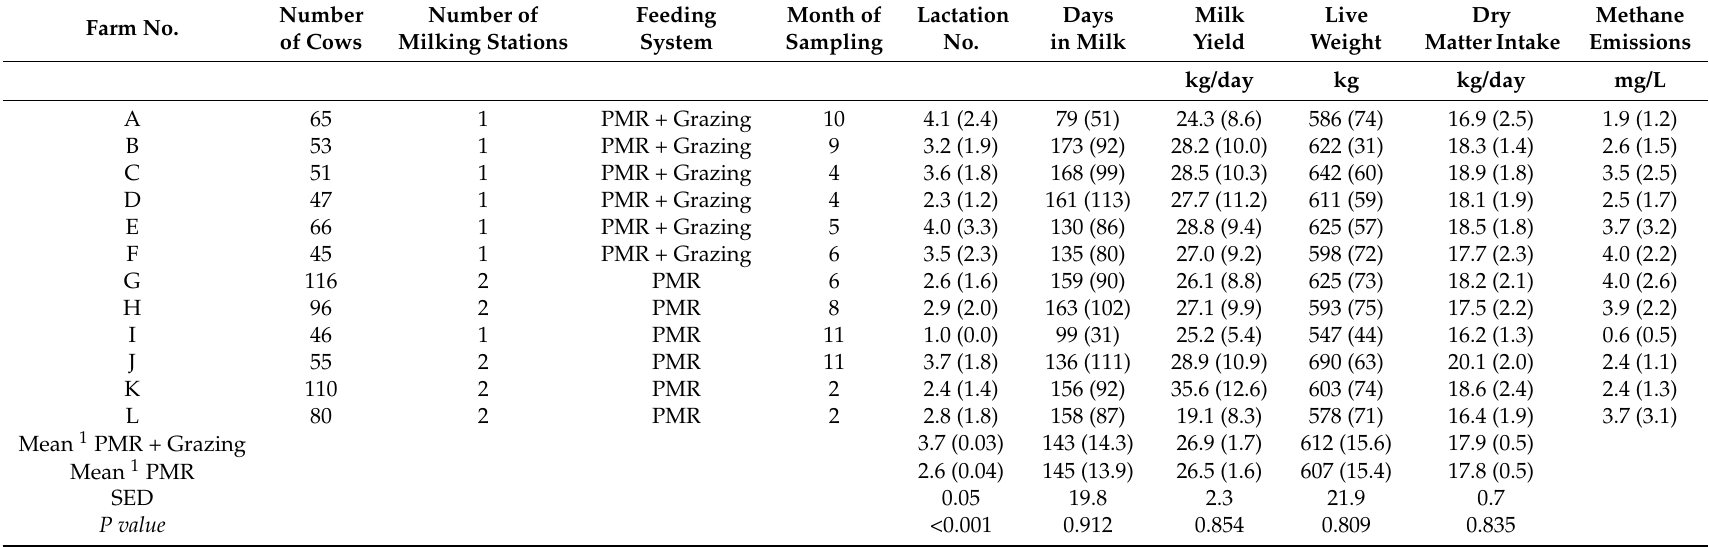
Table 1. Mean herd size, number of milking stations, feeding system category (Partial mixed ration (PMR) or PMR with grazing), month of year for sampling, and mean (s.d.) lactation number, days in milk, milk yield, live weight, dry matter intake and methane emissions per cow for each herd. Number Number of Feeding Month of Lactation Days Milk Farm No. of Cows Milking Stations System Sampling No. in Milk